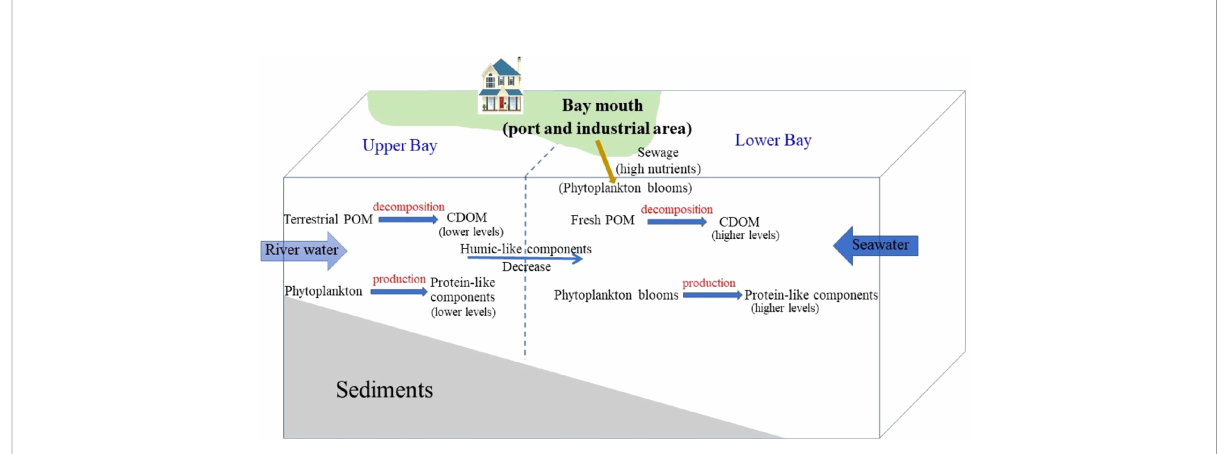
FIGURE 11 Simpli fi ed schematic sketch summarizing the major biogeochemical processes in Xi